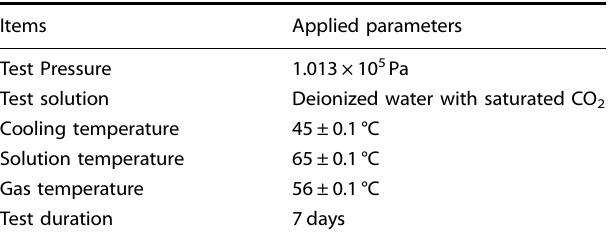
Table 2. Test parameters of TLC. Items Applied